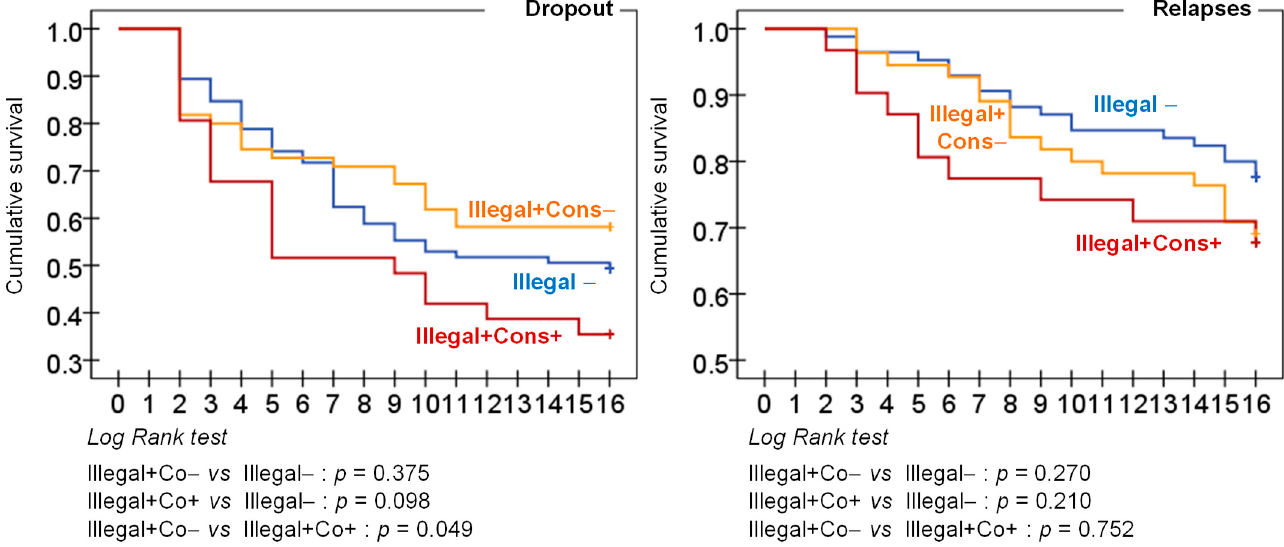
Figure 1. Survival functions for the rate of dropout and relapses. Note. Illegal − : without illegal behavior. Illegal + Cons − : with illegal behavior and without legal consequences. Illegal + Cons+: with illegal behavior and with legal consequences.